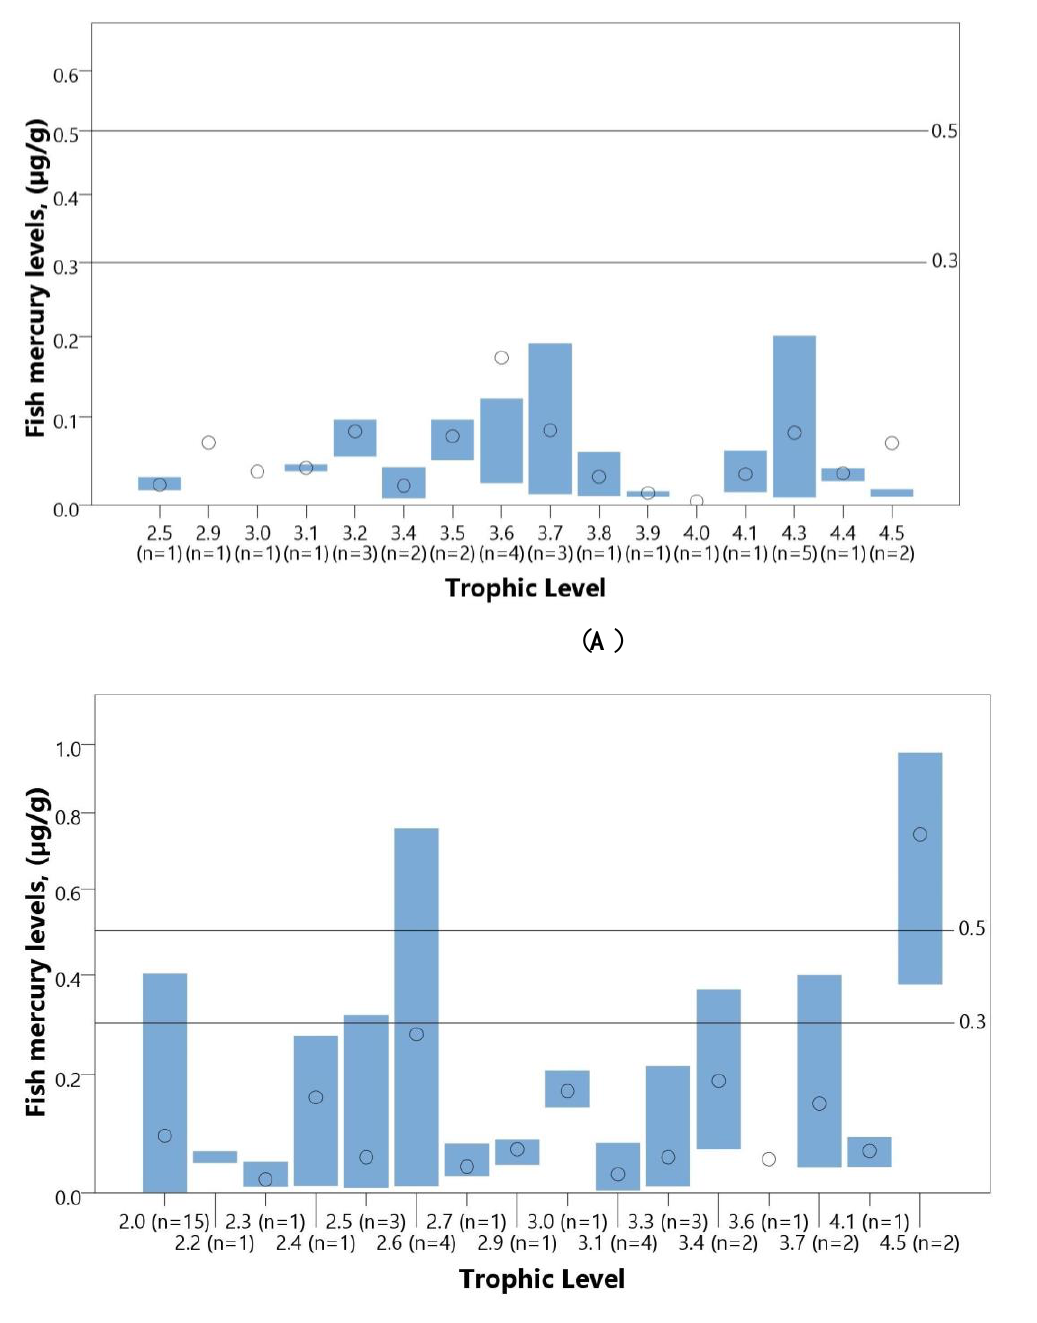
Figure 9. Mercury in marine ( A ) and freshwater ( B ) fish in Ghana. Bars represent range and dots represent means for fish at each trophic level (n = number of studies) across Ghana. For values below detection limit, standard protocol of dividing the detection limit by √𝟐 was followed. Where minimum and maximum measurements were not available for a study, the mean value is included in the overall mean for the trophic level, but no minimum or maximum was included in calculations. WHO/FAO (0.5 µg/g) and U.S. EPA (0.3 µg/g) guideline values are indicated as horizontal lines [37,38]. All studies except for two sampled in districts or regions with ASGM, but only one explicitly sampled at or close to an ASGM